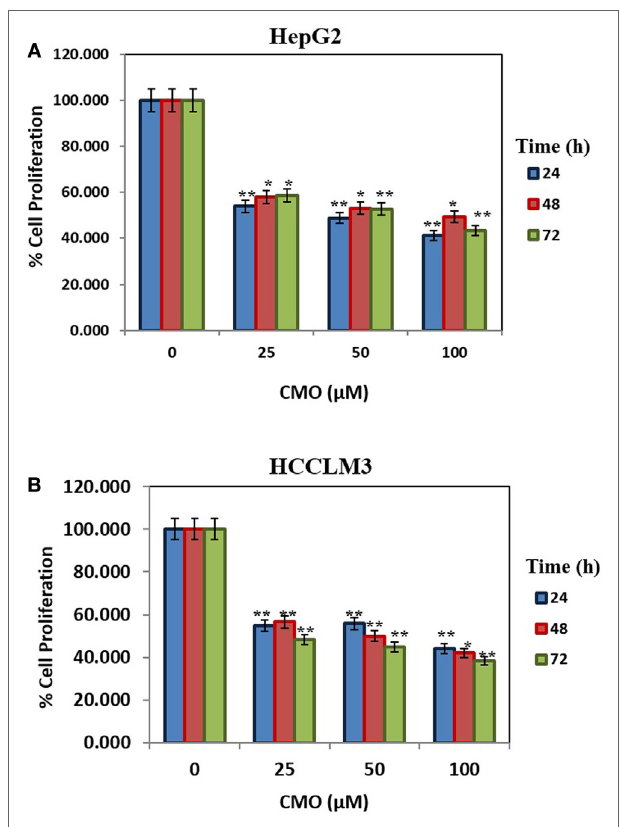
FigUre 1 | (a,B) CMO induces antiproliferative effect in time- and dose-dependent manner. HepG2 and HCCLM3 cells were plated in triplicate, treated with indicated concentrations of CMO, and then subjected to MTT assay after 24, 48, and 72 h to analyze proliferation of cells. The data are expressed as mean ± SD, compared with the untreated control (* p < 0.05, ** p <